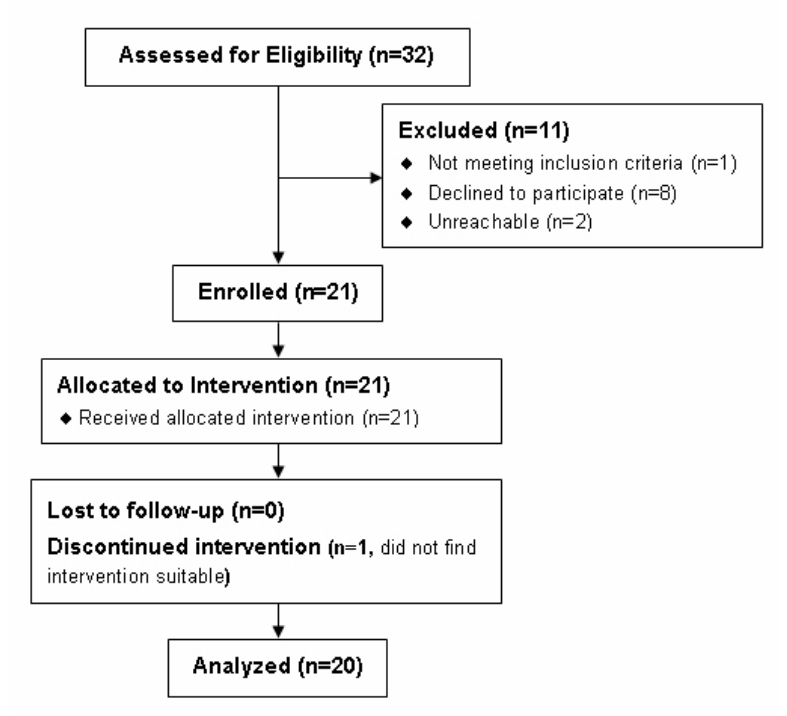
Figure 4. Participant enrollment and inclusion in to the study.